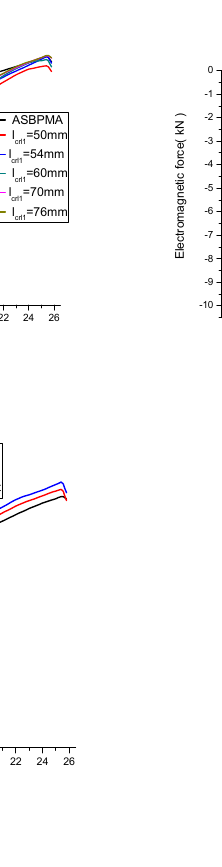
Figure 5. The characteristics curve of the presented ABSMPMA. ( a ) The characteristic of the mov- ing position vs. retaining force. ( b ) The characteristic of the length of mover vs. PM volume. ( c ) The characteristic of the initial mover position vs. PM volume.